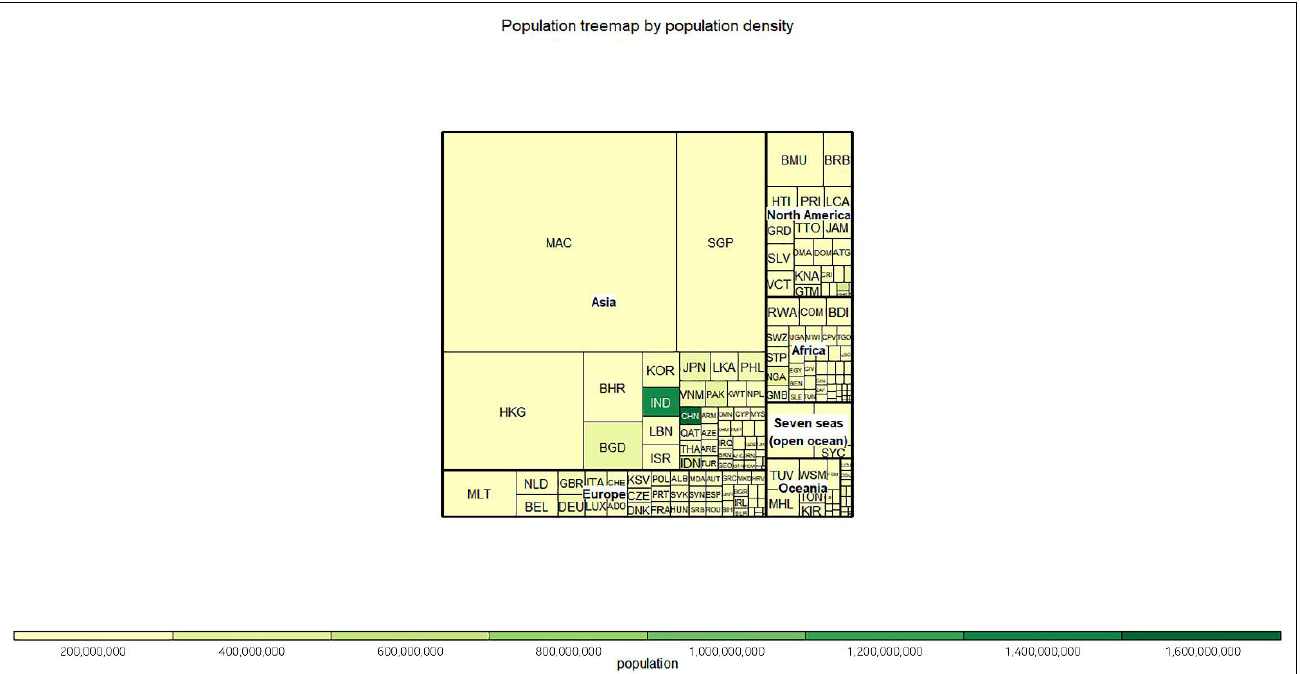
Figure 1. Population treemap of population density virtualization using R programming language. Figure 1 visualizes data on population density through treemap analysis using the R R programming language based on population density data published by the United programming language based on population density data published by the United Na- Nations tions (UN).